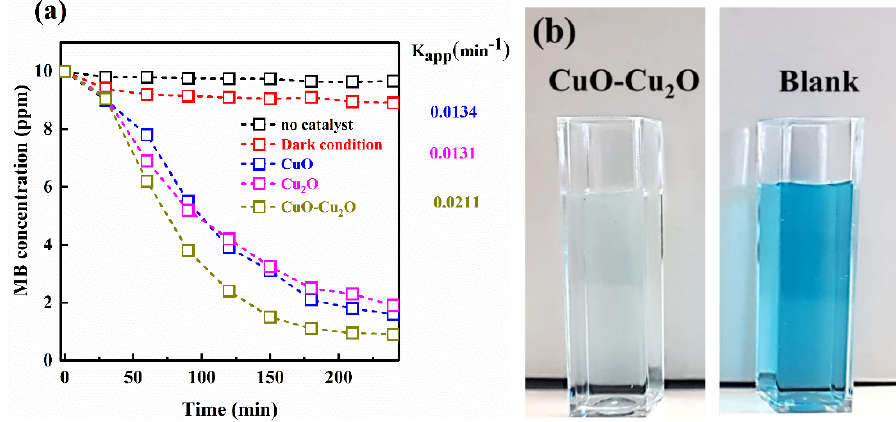
Figure 5. ( a ) Degradation profiles of MB vs. photocatalysis process time. ( b ) Images of the MB solution before and after photocatalysis by CuO – Cu 2 O.